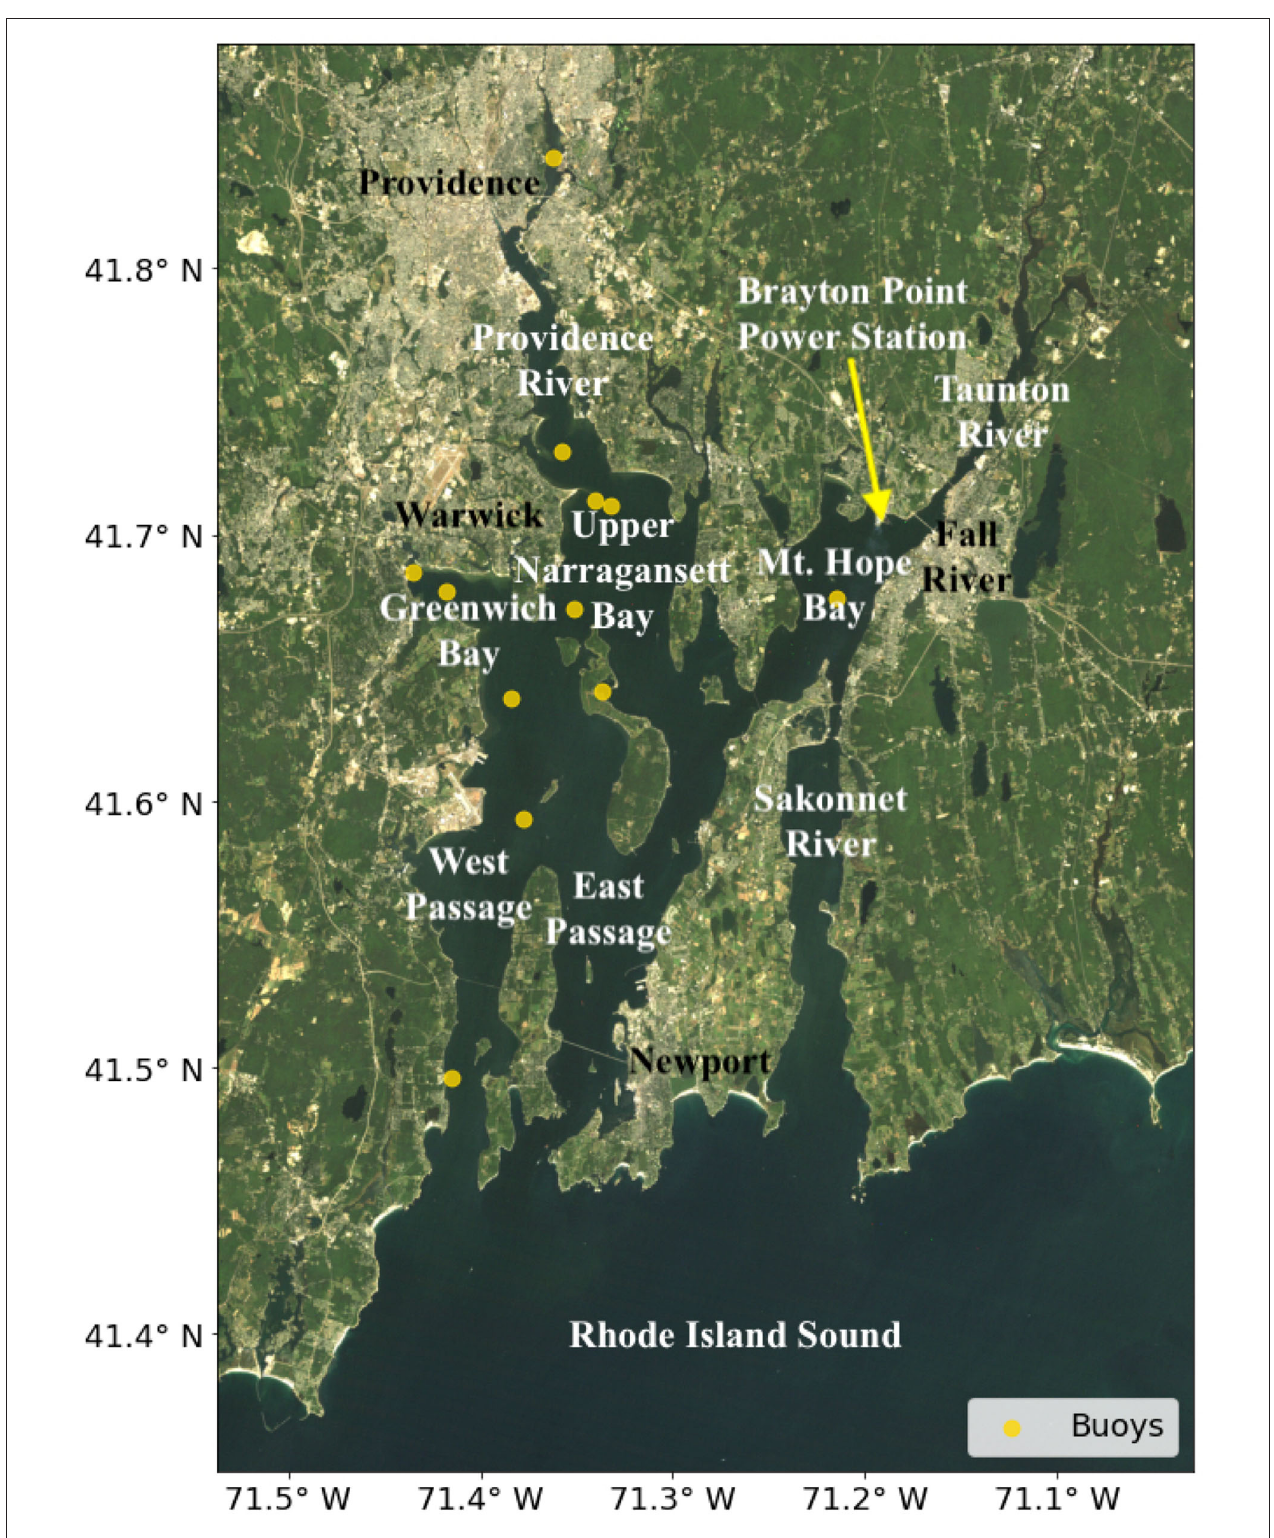
FIGURE 1 | Narragansett Bay shown in true color by a Landsat 5 scene on September 7th, 1984 with labeled regions and buoy locations. A plume of atmospheric discharge is faintly visible traveling southward from the Brayton Point Power Station.